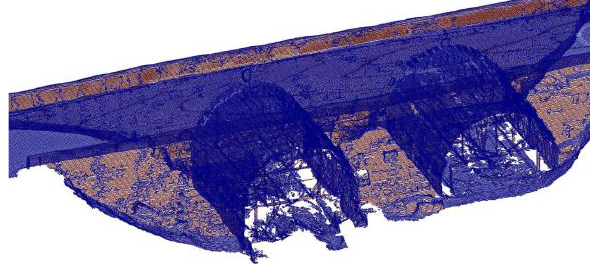
Figure 10: The cross-sections at 6cm intervals of the Roman